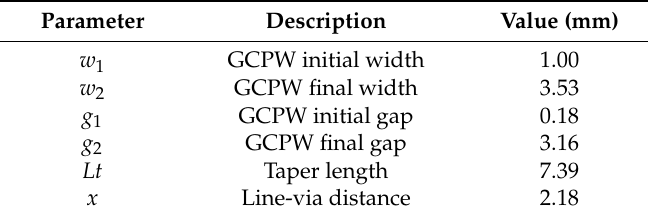
Figure 10. SIW-to-GCPW transition. ( a ) Geometry. ( b ) Simulated scattering parameters. Table 7. SIW-to-GCPW transition geometrical parameters.